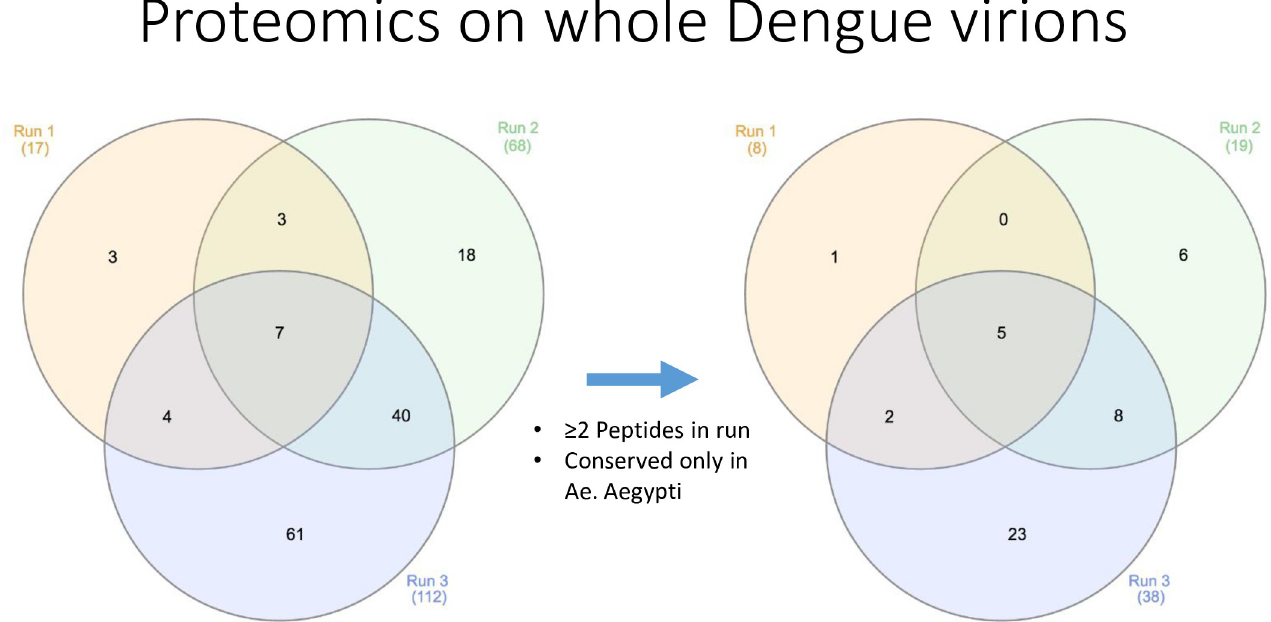
Fig 1. Illustration of a three-cycle Venn diagram with the hits recovered from the mass spectrometry assay before selection (left) and after selection (right) of the hits . Selection was based on the number of sequences found for every hit and their conservation in A . aegypti .